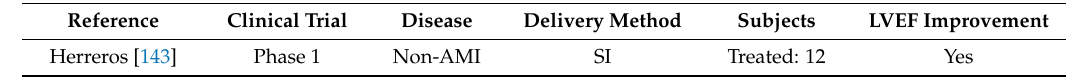
Table 8. Clinical trial with satellite cells for cardiac